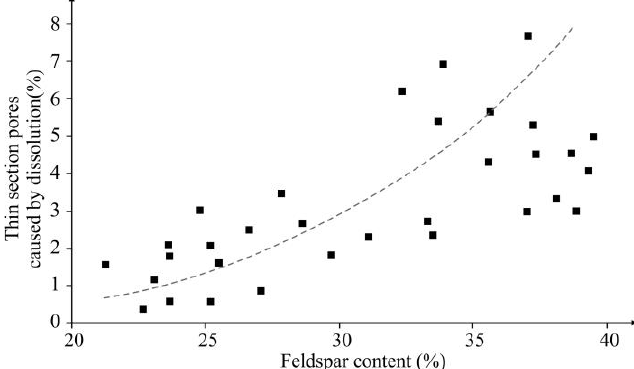
Figure 13. Secondary dissolution pores versus feldspar content.